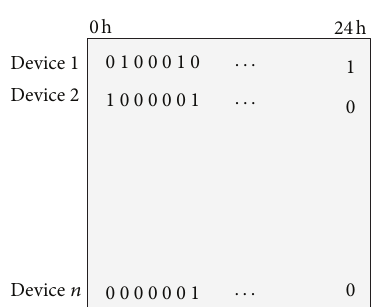
Figure 6: Solution encoding of the scheduling